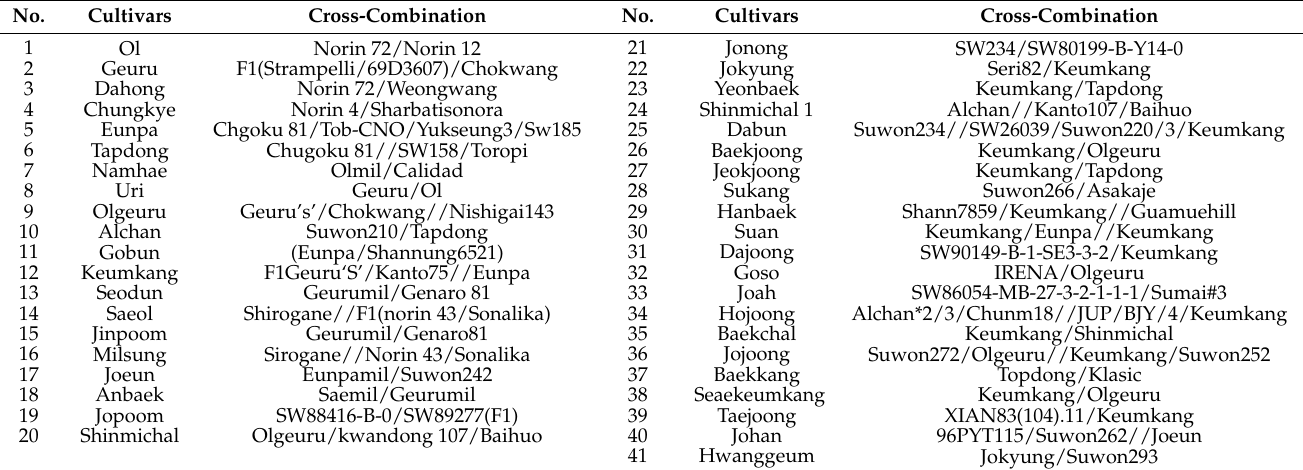
Table 1. List of 41 wheat